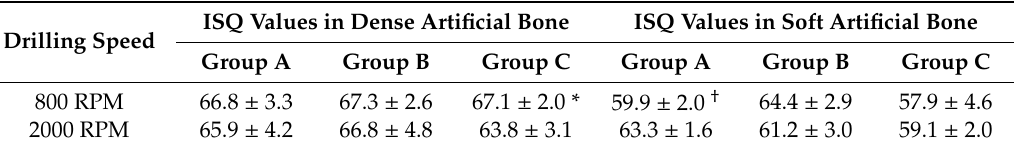
Table 1. Mean ± standard deviation of the implant stability quotient for narrow diameter implants placed in dense and soft artificial bone at 800 and 2000 RPM. Drilling